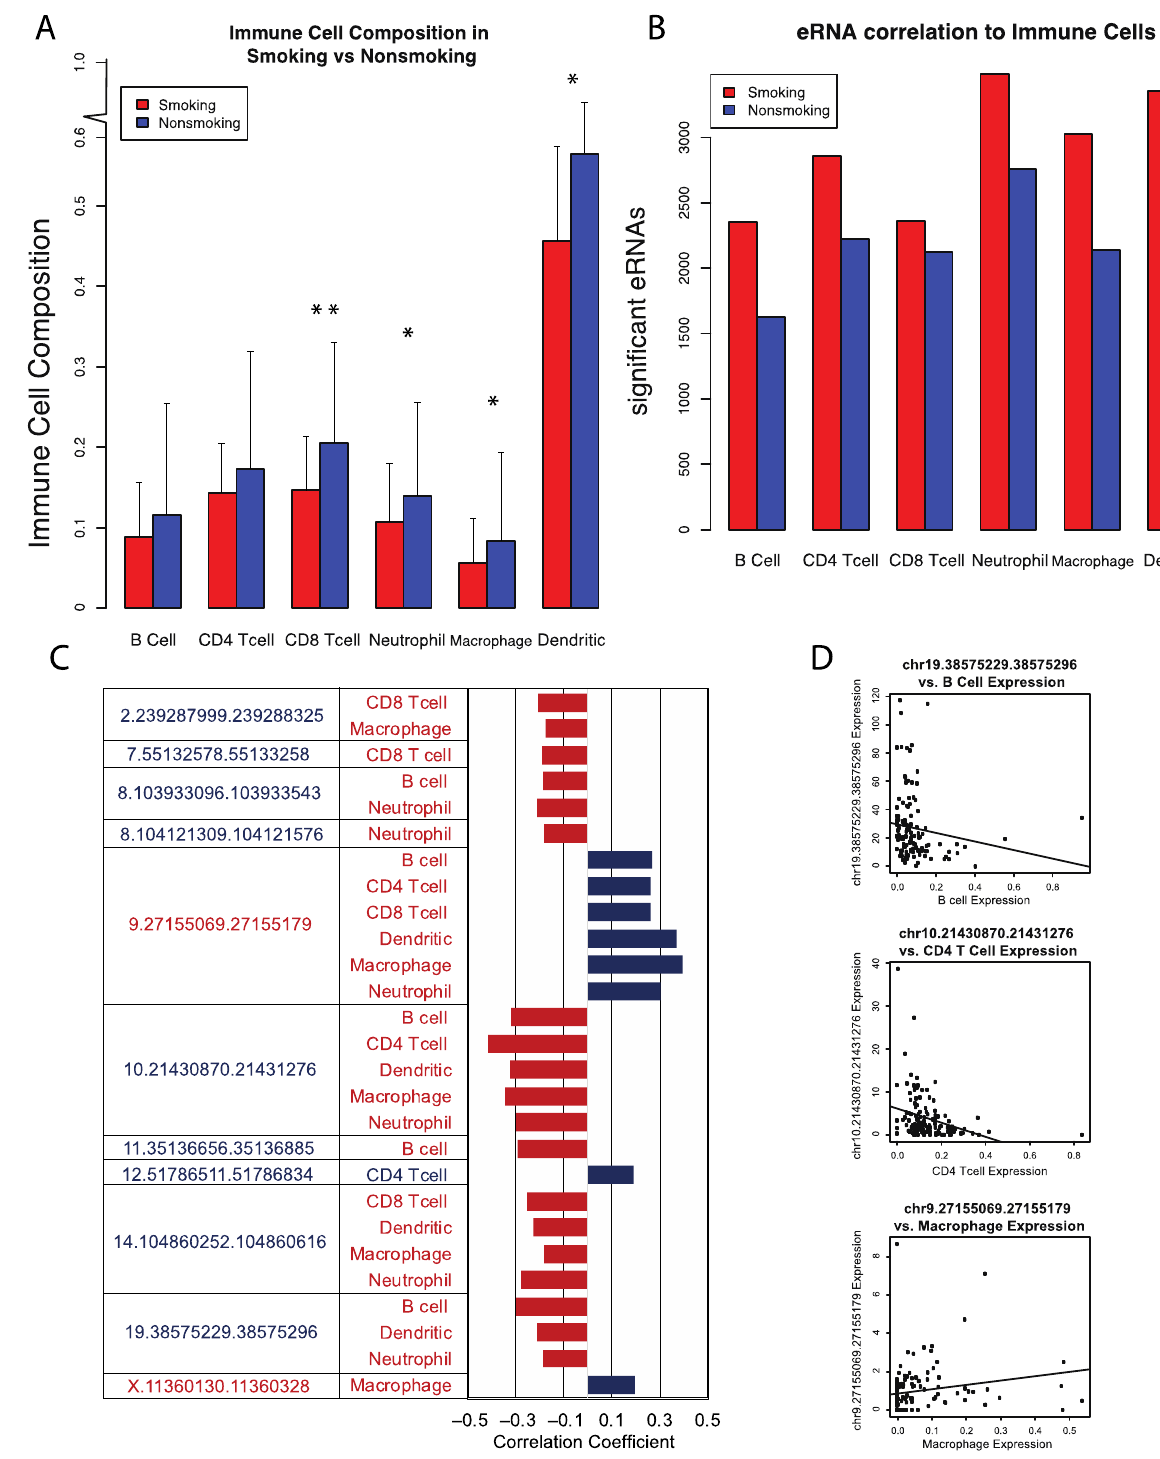
Figure 3. Correlation to immune-associated elements. ( A ) Bar graph comparing immune cell composition in smoking-onset LUSC and nonsmoking-onset LUSC. Red indicates smoking-onset LUSC samples, and blue refers to nonsmoking-onset LUSC samples. Overall, immune cell abundance was higher in nonsmoking LUSC samples. Error bars indicate the standard deviation. Homoscedastic t -tests were performed to compare immune cell compositions of the cohorts (** p < 0.001, * p < 0.05). ( B ) Bar graph comparing significant eRNA correlations to immune cell abundance in smoking-onset LUSC and nonsmoking-onset LUSC. Red indicates smoking-onset LUSC samples, and blue refers to nonsmoking-onset LUSC samples. The data suggest that there is a greater amount of significant eRNAs associated with immune cells in smoking-onset LUSC samples. ( C ) Bar graph summarizing immune cell correlations to the 16 critical eRNAs previously